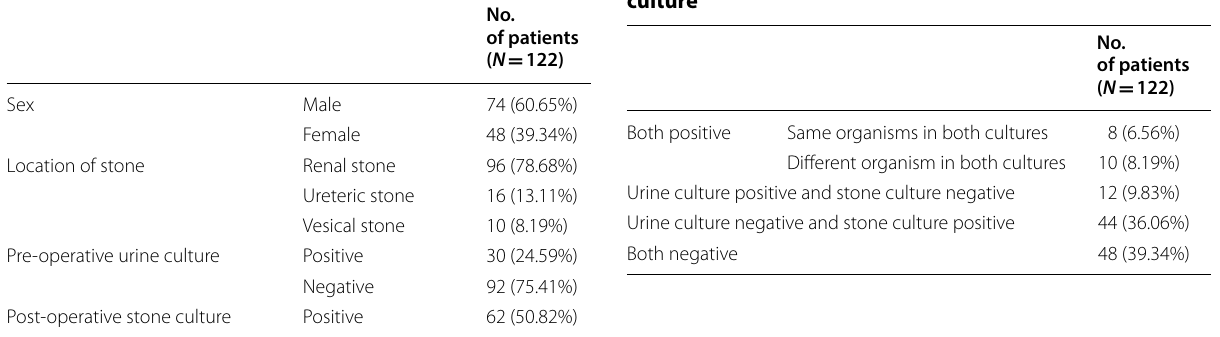
Table 1 Distribution of patients with urolithiasis